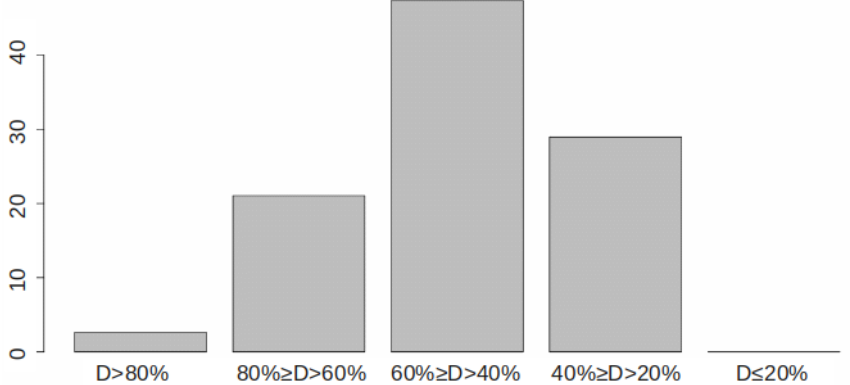
Figure 3. Histogram of the number of Agile ICOs per percentage of Token to be sold during the